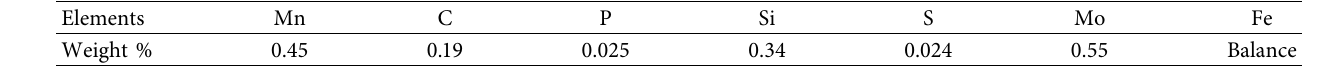
Table 1: SA209-T1 chemical composition (OES method).